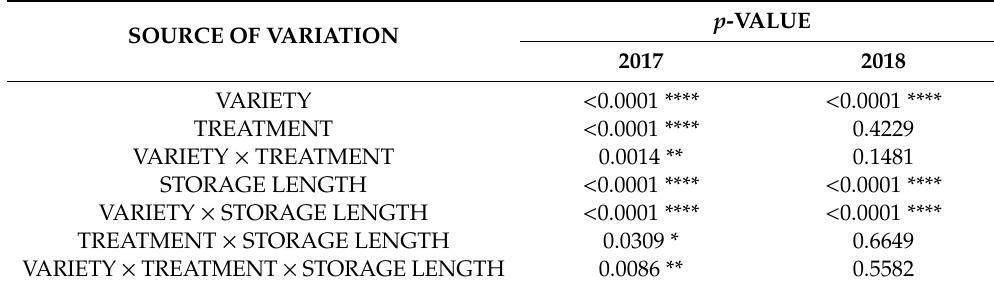
Table 3. ANOVA table for Hunter L-values that indicate fry color of the chipping varieties.